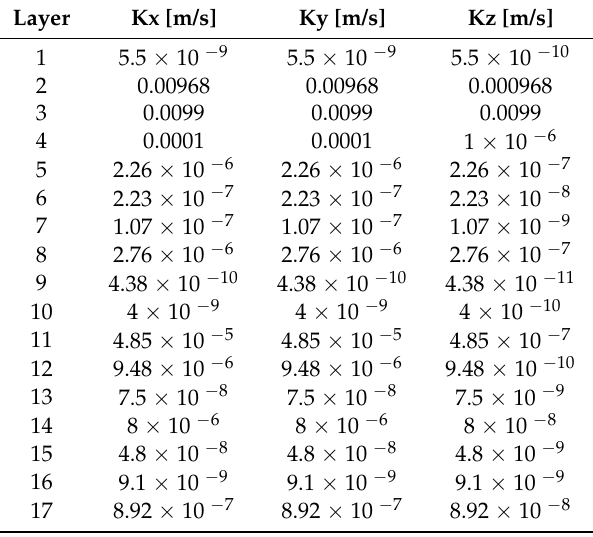
Table 11. Hydraulic conductivity summary from the calibration in steady state.